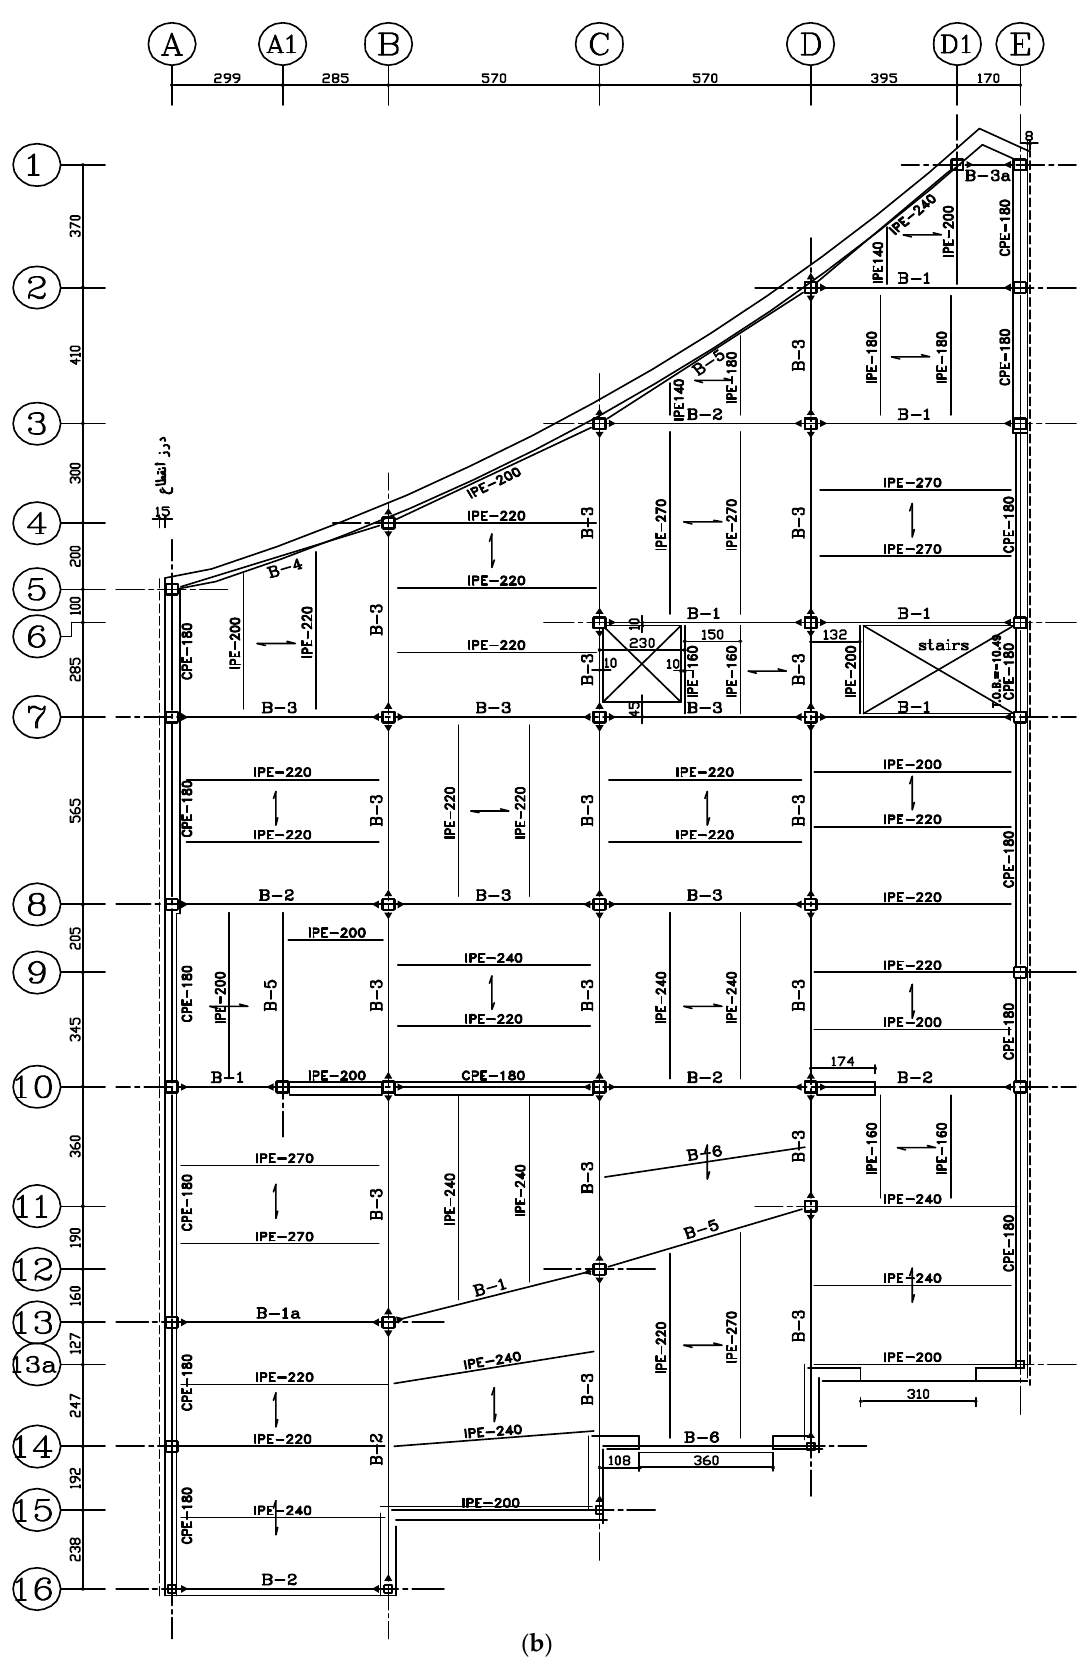
Figure 3. Frame plans of two case study buildings: ( a ) concrete frame and ( b ) steel frame.